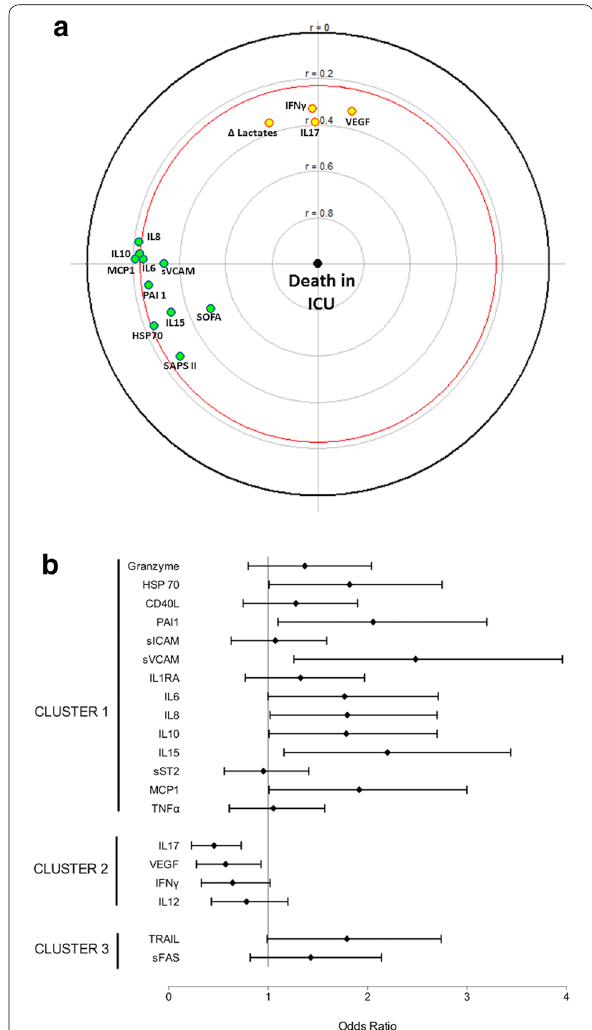
Fig. 4 Forest plot for odds ratios ( a ) and focused principal component analysis (FPCA, b ) for the association between sepsis mediators and intensive care unit mortality. b Correlation of ICU mortality (dependent variable at the center) with sepsis mediators at day 1, patient’s severity (as assessed by SAPS II score), organ dysfunction (as assessed by SOFA score at septic shock onset) and lactate clearance (relative difference between lactate concentration at septic shock onset and after 24 h of resuscitation) as a surrogate of early sepsis resolution. See Fig. 2 legend for details on FPCA. Variables positively and negatively correlated with ICU mortality are in green and yellow, respectively. See text for sepsis mediators’